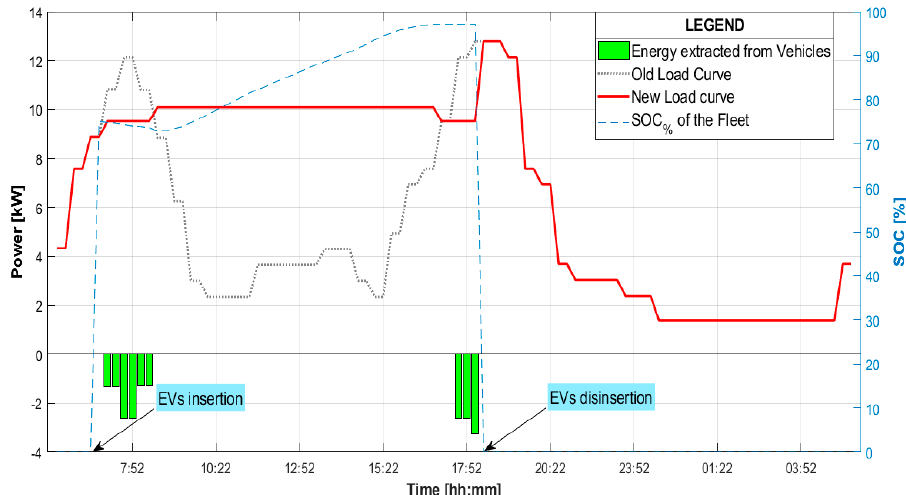
Figure 21. Comparison between the old load curve and the new load curve.